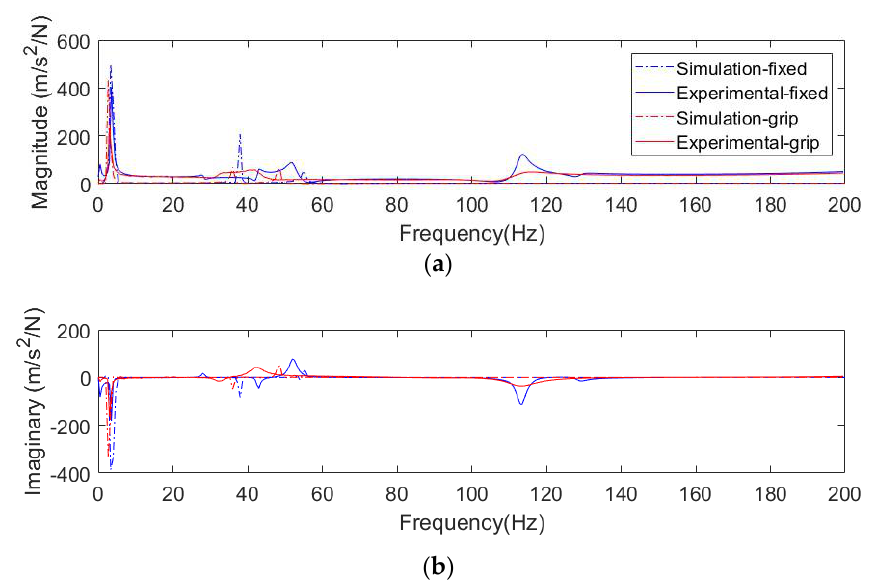
Figure 2. Simulated and a representative experimental FRF for both boundary conditions. ( a ) Magnitude of the FRF from 0–200 Hz; ( b ) Imaginary component of the FRF from 0–200